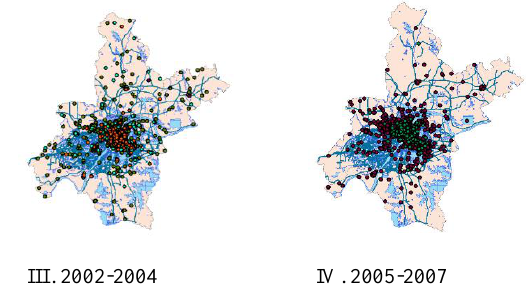
Figure 1. Spatial distribution of enterprises registered in Wuhan among different time periods